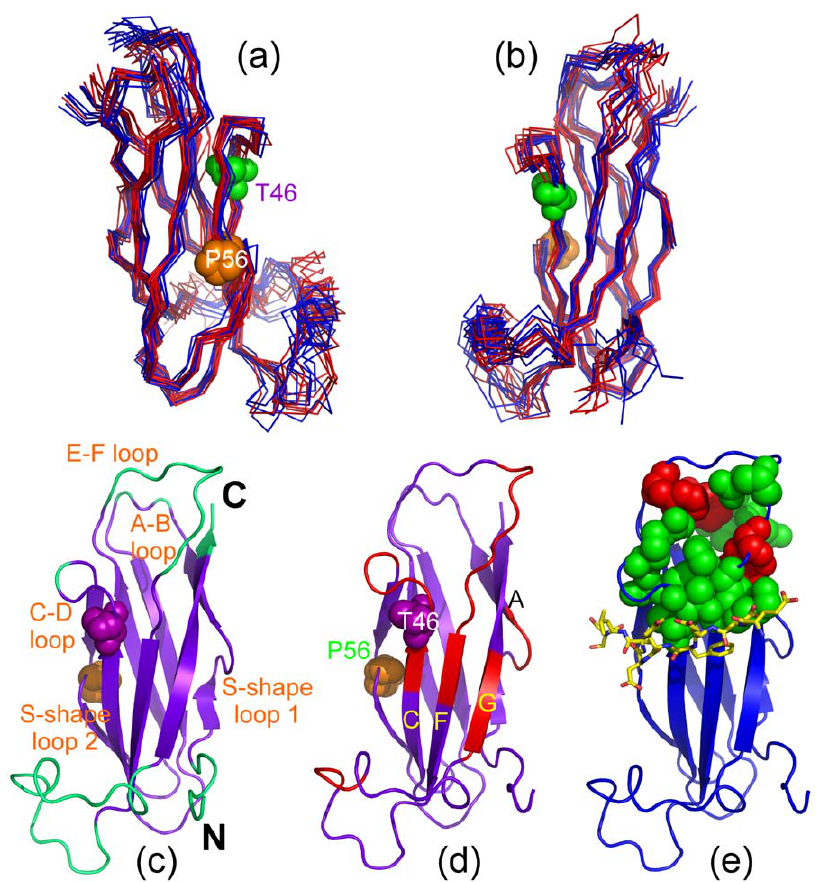
Figure 8. Dynamical behaviors. (a–b). Structure snapshots (one structure for 1-ns interval) for two independent MD simulations for the WT- (blue) and T46I- (red) MSP domains. (c). The MSP structure in which cyan is utilized to indicate the WT-MSP residues with RMSF values larger than the average. (d). The MSP structure in which red is used to indicate T46I residues whose RMSF values are larger than those of the WT-MSP domain. The two mutation residues causing ALS, P56S and T46I, were displayed as spheres. (e). The MSP structure in which green is used to indicate residues whose hydrogen bonds occupancy difference is larger than 10% between WT and T46I while red is for residues whose hydrogen bonds occupancy difference is larger than 10% between T46I and WT.